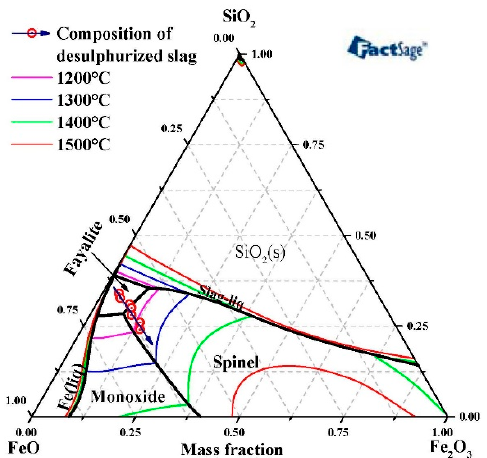
Figure 2. Phase diagram of slag: desulphurization slag composition in the ternary phase diagram of FeO-Fe 2 O 3 -SiO 2 (obtained from FactSage).